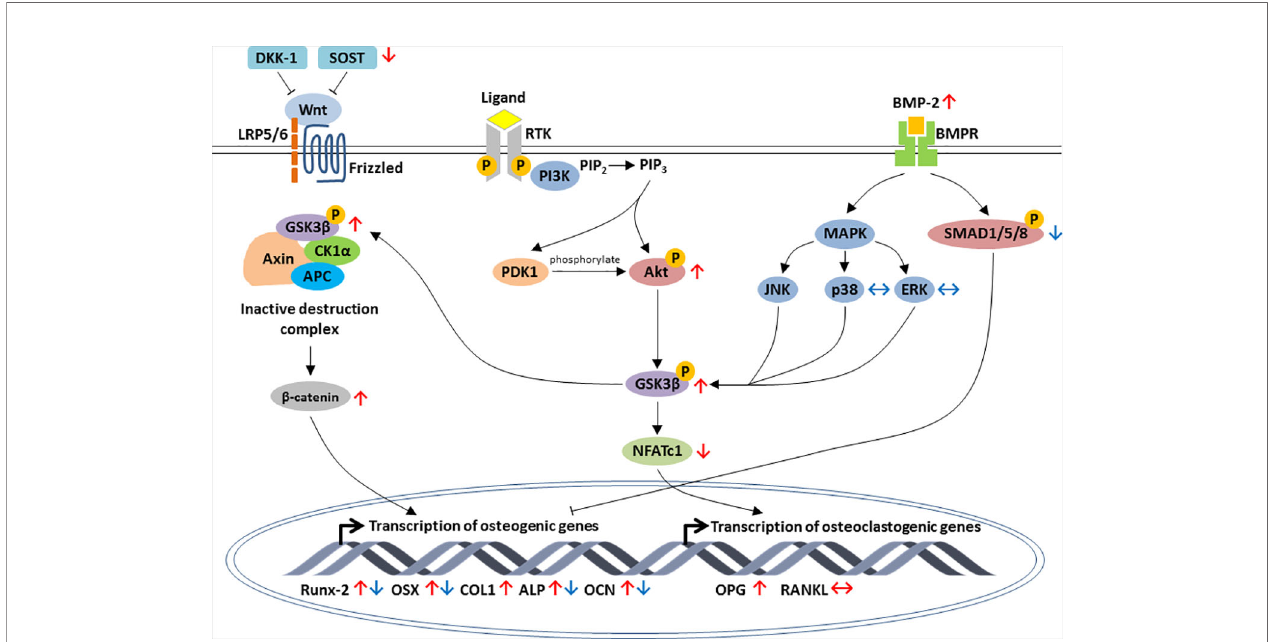
FIGURE 1 | Schematic diagram depicting the regulation of osteoblastic-speci fi c genes expression by lithium through activation of three major signaling pathways, including the canonical Wnt/ b -catenin, PI3K/Akt and BMP-2 signaling pathways. In Wnt/ b -catenin pathway, lithium inhibits the expression of sclerostin (SOST) as well as increases phosphorylation of GSK3 b and accumulation of b -catenin. Through PI3K/Akt pathway, the activation of Akt by lithium leads to the inhibition of GSK3 b and downregulation of NFATc1. Lithium also enhances osteogenic differentiation by increasing BMP-2 expression. The effects of lithium are indicated by red arrows. For early stage of osteogenic differentiation, lithium inhibited the expression of osteogenic markers by increasing phosphorylation of suppressor of mothers against decapentaplegics (SMADs) in BMP-2 signal transduction pathway (the effects of lithium are indicated by blue arrows). Arrow pointing upward ( ↑ ) indicates an increase and pointing downward ( ↓ ) indicates a decrease. Equivalent arrow ( ↔ ) indicates no